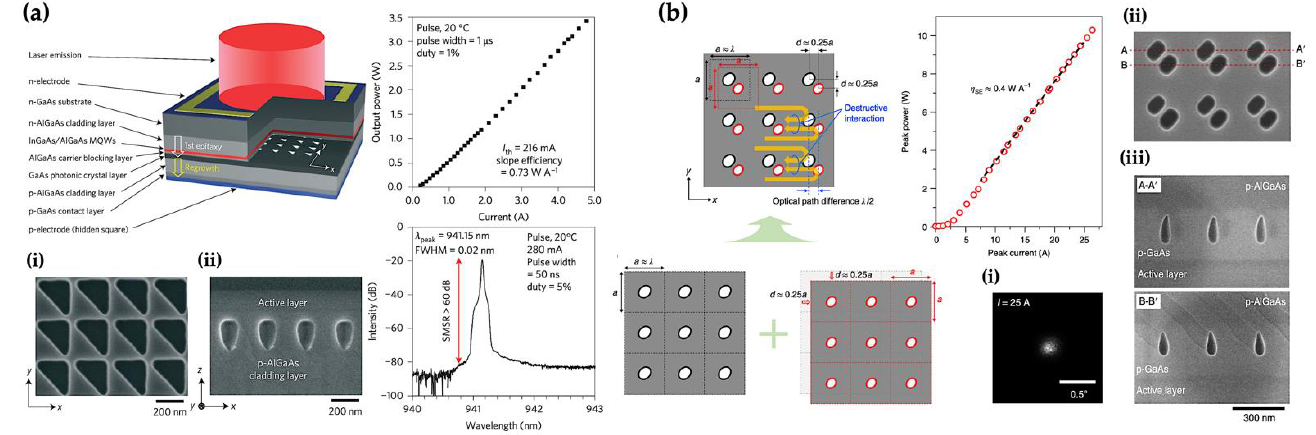
Figure 8. ( a ) Schematic illustration of device structure and the corresponding lasing characteristics operated under room temperature pulsed conditions [77]. A watt-class laser light emission with high beam quality can be achieved with such a photonic-crystal laser device. Insets: ( i,ii ) The SEM images show the top view and the cross-sectional view before and after the burial by metal–organic chemical vapor deposition (MOCVD) regrowth, respectively. After burial, well-defined photonic-crystal air holes can be observed. ( b ) Schematic illustration for the concept of a double-lattice photonic crystal and the corresponding lasing characteristic operated under room-temperature pulsed conditions [45]. With the adoption of such double-lattice photonic-crystal structure, remarkable 10-watt-class laser light emission with quite narrow beam divergence can be attained. Insets: ( i ) Measured far-field pattern for such a laser device operated with an injection current of 25 A. A quite narrow divergence angle of less than 0.3° can be observed. ( ii,iii ) The SEM images show the top view and the cross-sectional view before and after the MOVPE regrowth technique, respectively.